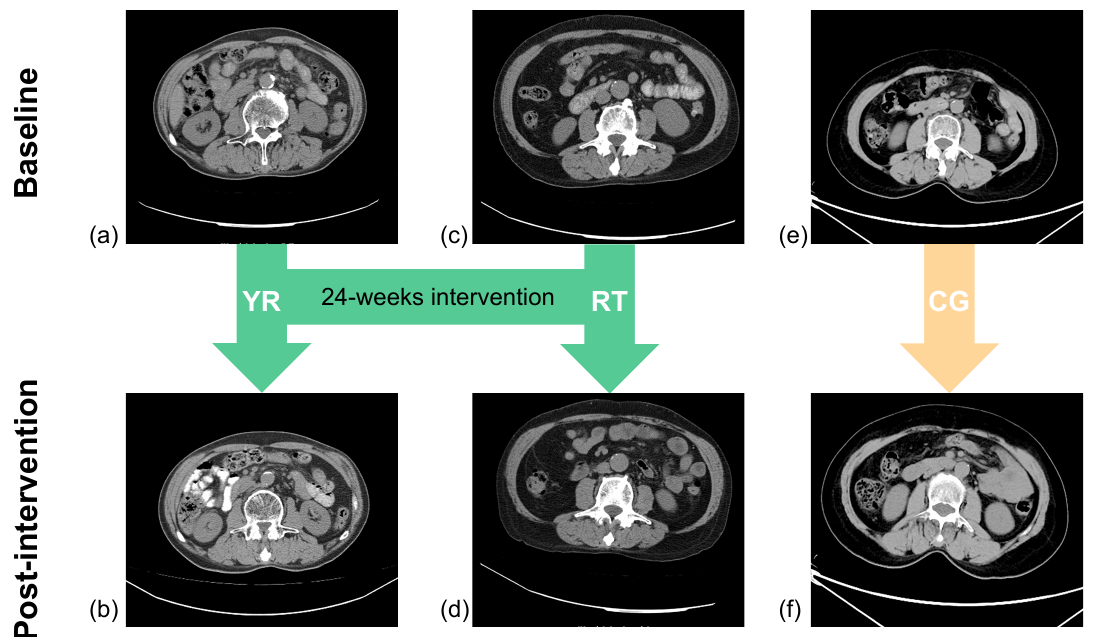
Figure 3. This figure shows the QCT scans of the participants before and after the intervention.